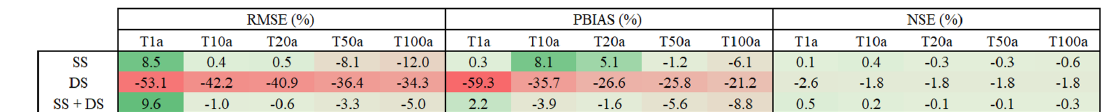
Table A1. Obtained deterioration (–) or improvement ( + ) towards the best regionalisation technique (KED[LS | SS]) when no long series